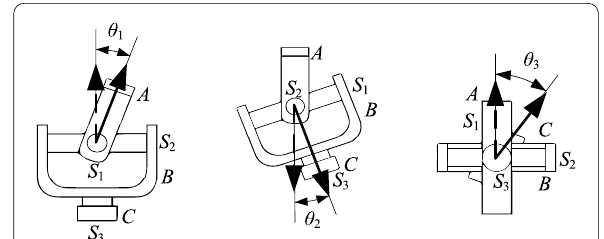
Figure 8 Diagram of the equivalent spherical joint